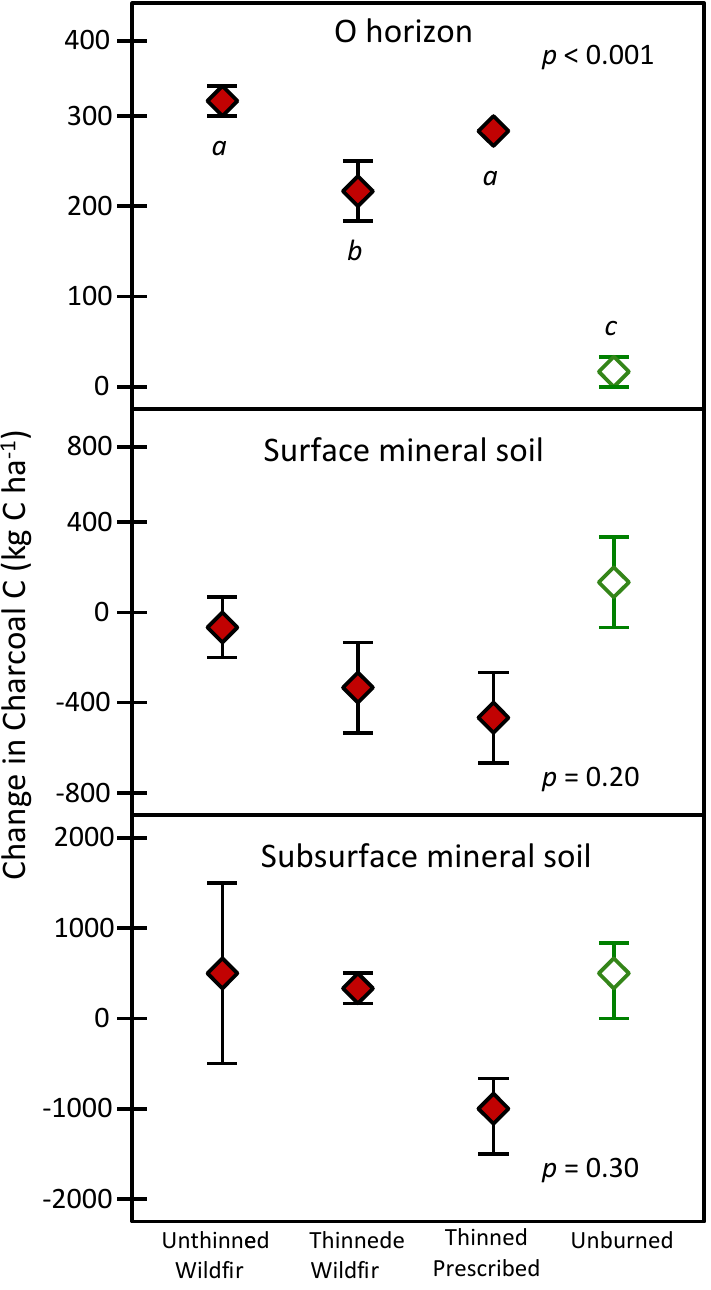
Figure 2. Change in charcoal C mass (mean ± SE, n = 2) for O horizon 0.5–20 mm charcoal and mineral soil < 4 mm fraction. P values are from single factor ANOVA. For O horizon, treatments not identified by the same letter are different, Tukey test, α = 0.05. p <